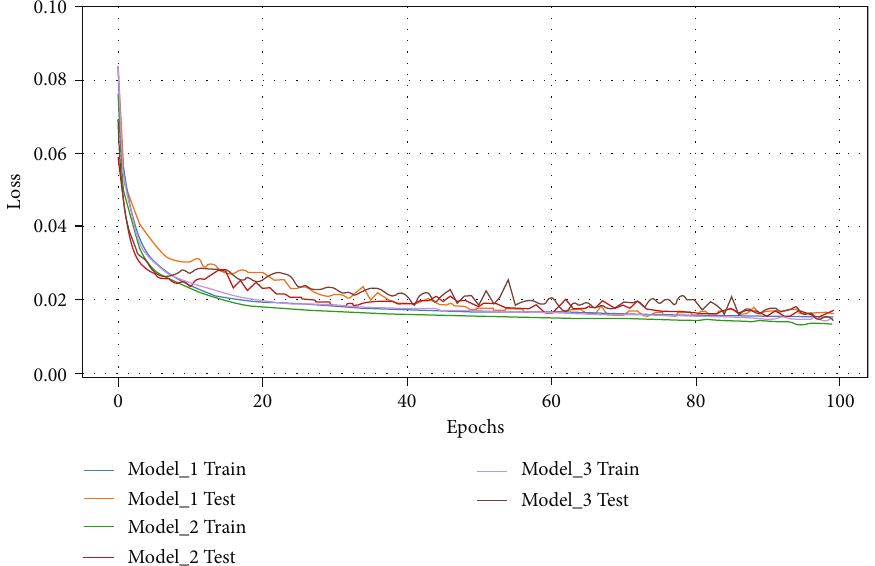
Figure 9: Behavior of the loss function in the selected